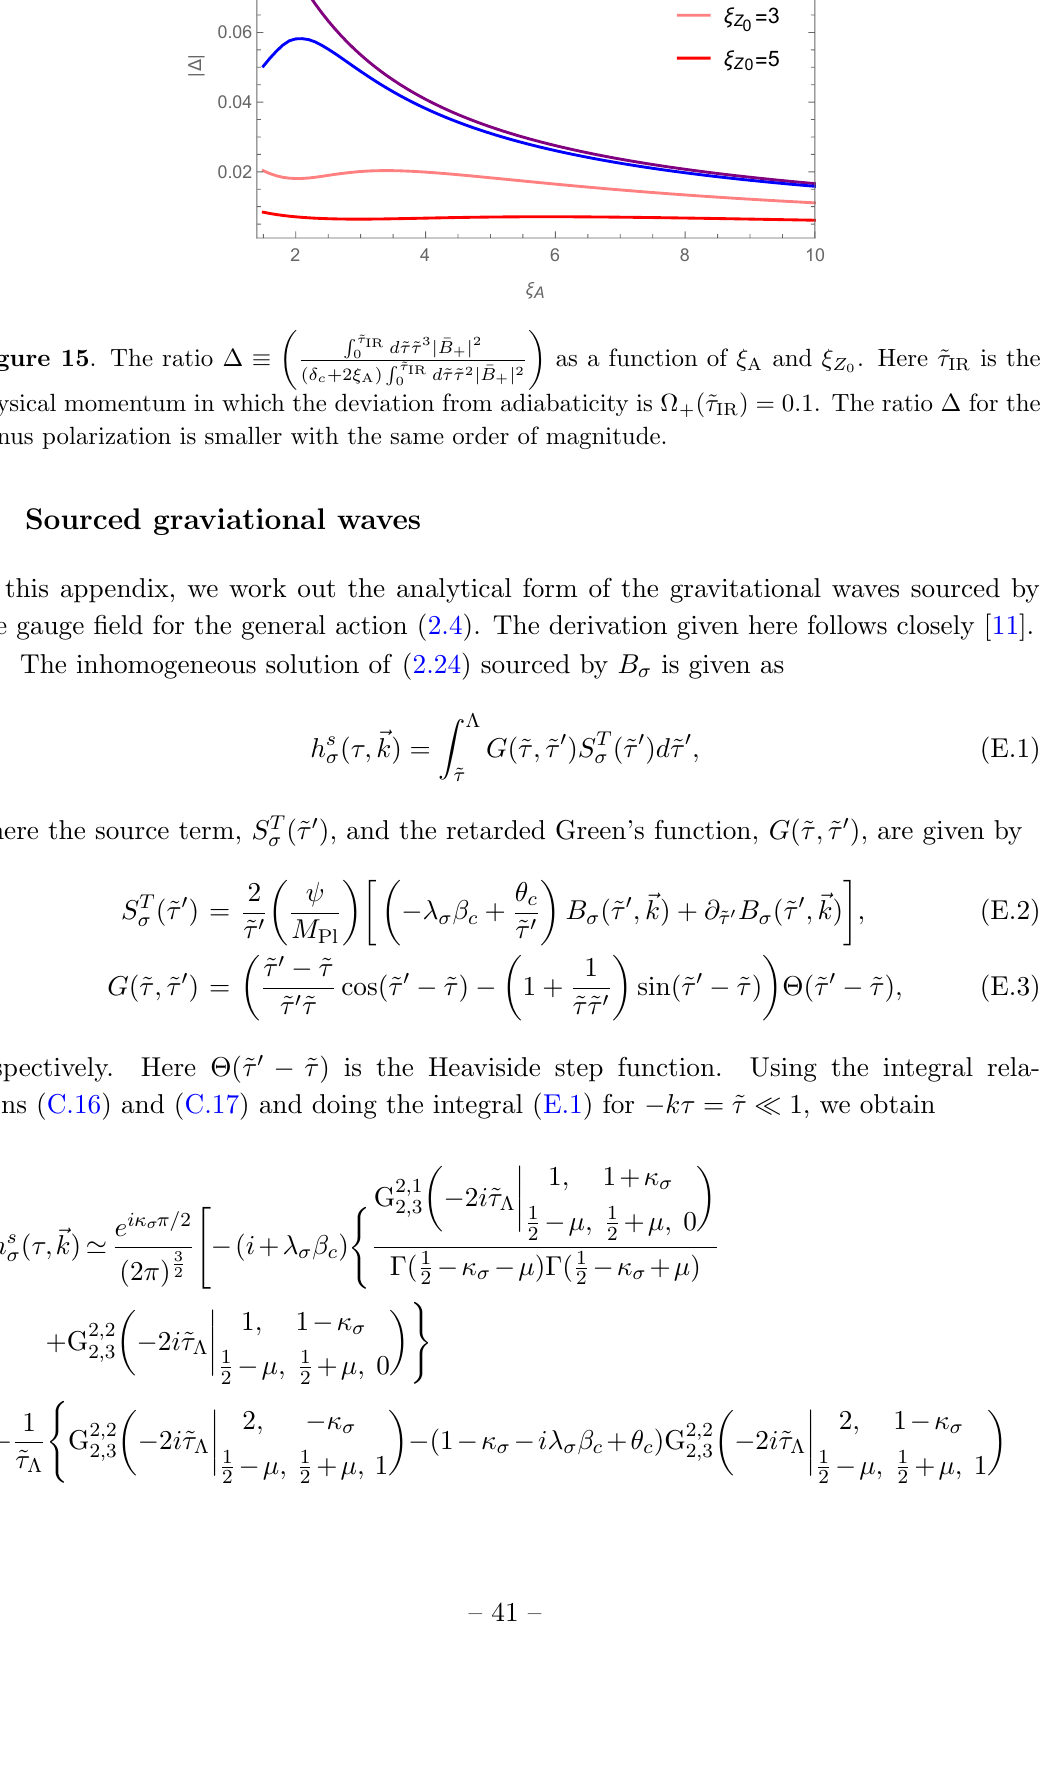
(cid:18) (cid:19) R ~ (cid:28) IR as a function of (cid:24) A and (cid:24) Z 0